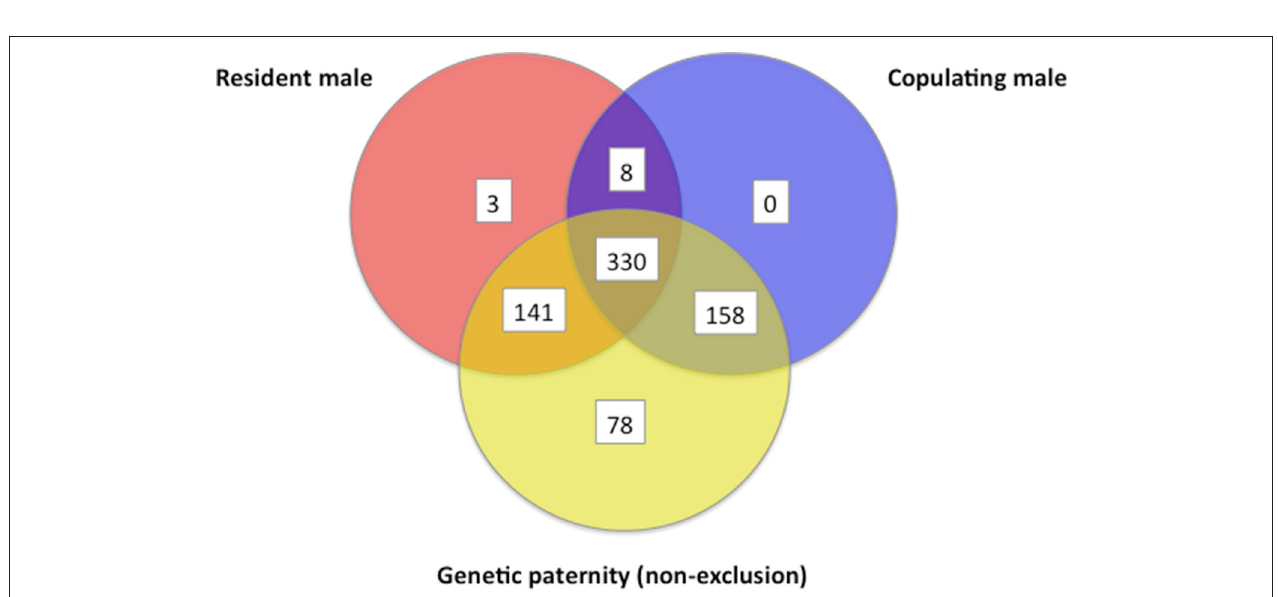
FIGURE 13 | Venn diagram that shows information about a female’s sexual partner(s) regarding (a) whether the male was a resident of the female’s home territory, (b) whether the male was observed to copulate, and (c) whether one of the copulating males could be assigned paternity by non-exclusion, as determined by seven polymorphic microsatellites. These data are from white-tailed prairie dogs at the Arapaho National Wildlife Refuge, Colorado USA, from 2006 through 2012.